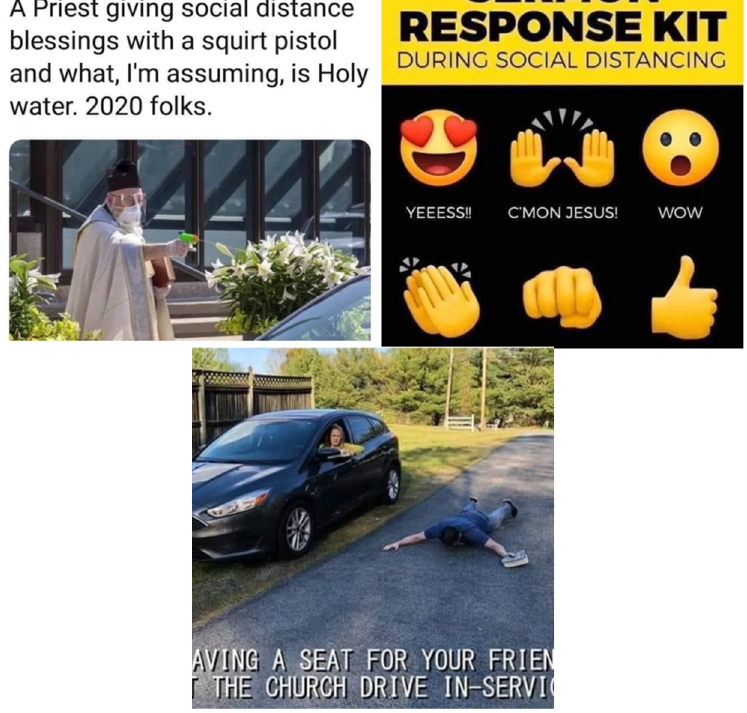
Figure 6. Examples of memes showing playful interpretations of how leaders and church members embrace social-distancing and create alternatives religious and social practices.